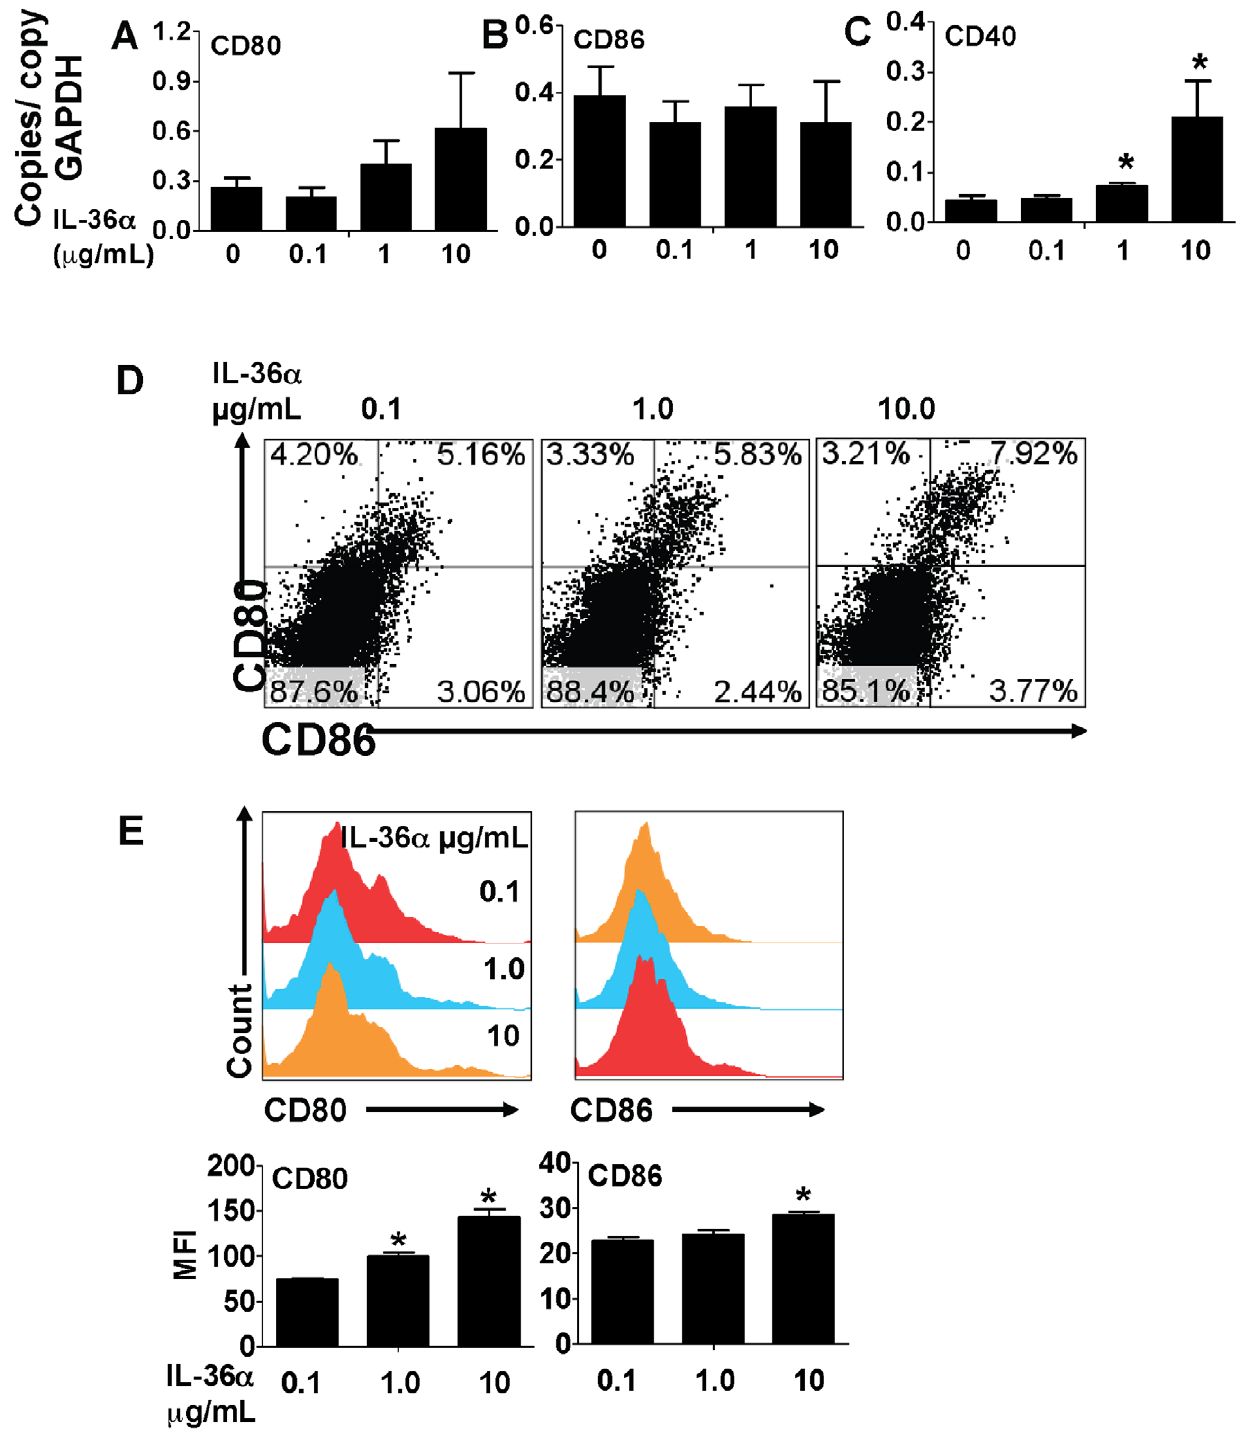
Figure 7. IL-36 a induced the expression of T cell costimulatory molecules in splenic CD11c + cells. A–C) Transcript expression of the co- stimulatory molecules CD80, CD86 and CD40 in splenic CD11c + cells 2 h following incubation with increasing concentrations of IL-36 a . Transcript expression was evaluated by SYBR-Green based quantitative real-time PCR. *Indicates significant differences ( P , 0.05 ) compared to 0 m g/mL group. Data represent mean 6 SD from quadruplicate samples from one of two representative experiments. D) Flow cytometric evaluation of splenic CD11c + cells 24 h following incubation with increasing concentrations of IL-36 a for 2 h. E) Cell surface expression of co-stimulatory molecules in splenic CD11c + cells 24 h following incubation with increasing concentrations of IL-36 a for 2 h. MFI – mean fluorescence intensity. *Indicates significant differences ( P , 0.05 ) compared to 0.1 m g/mL group. Data represent mean 6 SD from triplicate samples from one of two representative experiments.